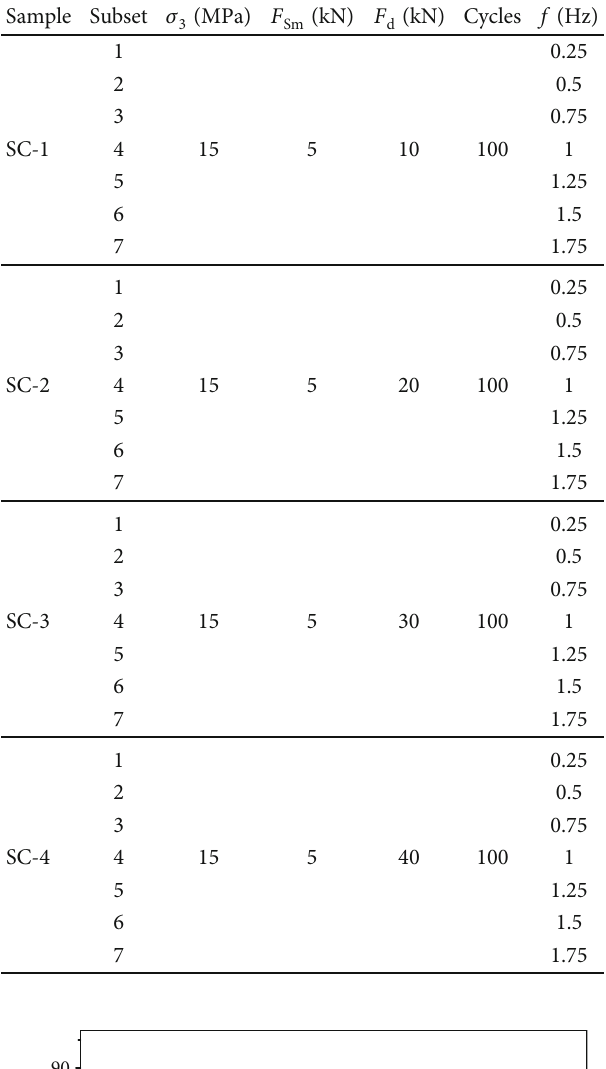
Table 1: Test parameter for cyclic axial load conditions.